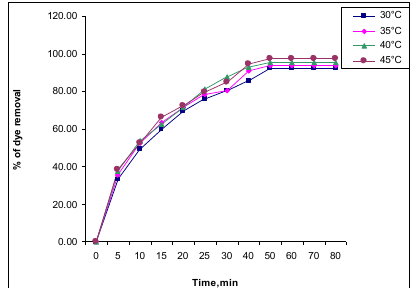
Figure 4 Effect of temperature on the adsorption of AV 49 dye on to PAC at initial concentration of 50 mg/L (adsorbent dosage, 100mg; pH,